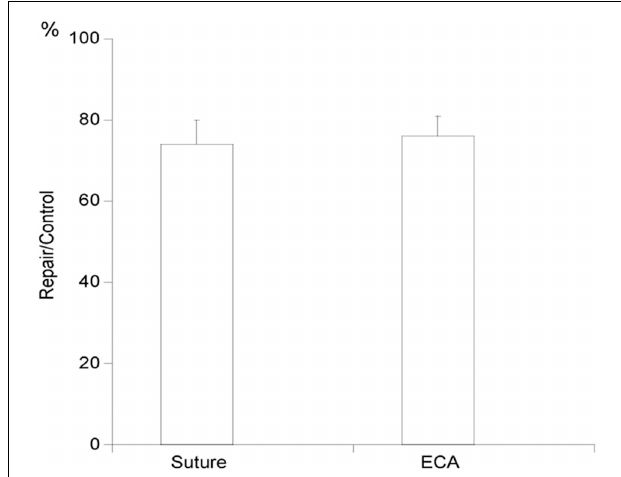
FIGURE 5 | Histogram representing the wet weight, expressed as mean (SD), of the lateral gastrocnemius muscles (LGCs) 6months after transection and repair of the left sciatic nerve with either ECA or epineurial sutures. Each column shows the weight relationship (%) of the LGCs calculated by dividing the muscle mass of the repaired side by the muscle mass of the control side ( n = 8 in each